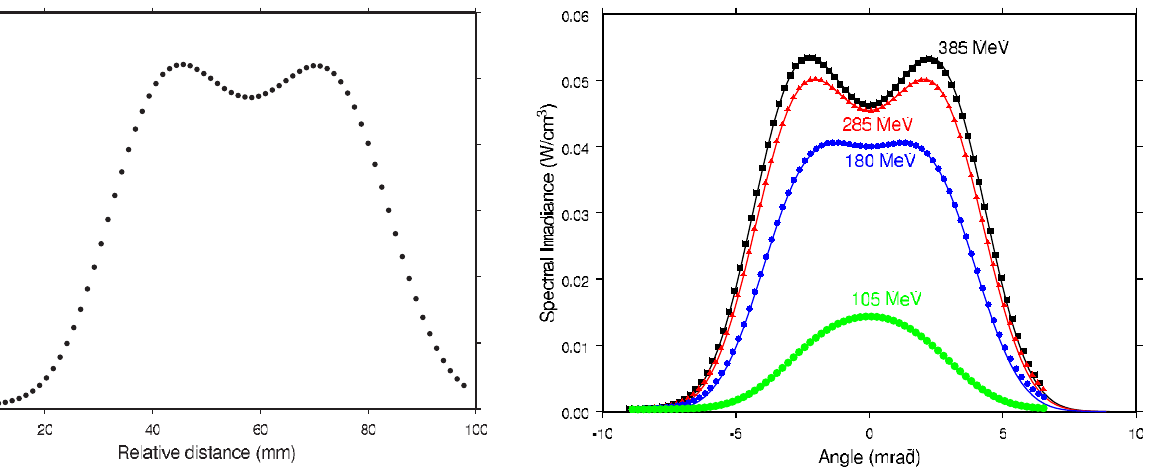
FIG. 6. Photocurrent measured as a function of the vertical displacement from FR1 with 285 MeV electron energy. The signal is normalized to 1 mA of SURF current.